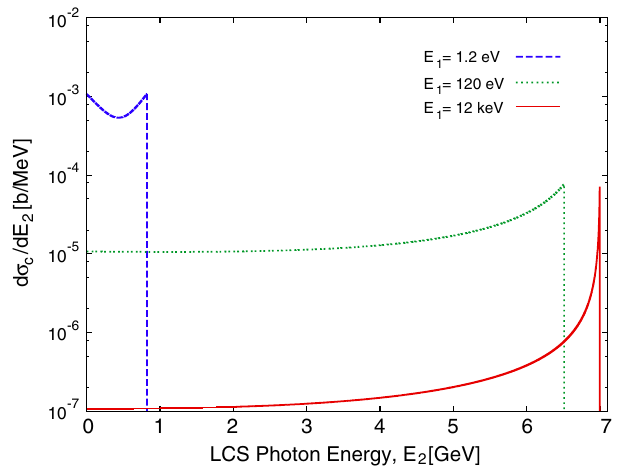
FIG. 3. Energy-differential cross section of Compton scattering for 7 GeV electrons and laser photons at three different energies of 1.2 eV, 120 eV and 12